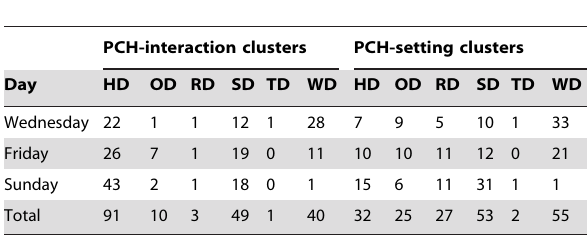
Table 1. Daily and total subject-days in each setting- dominated cluster for clustering on PCH-interaction (left) and PCH-setting